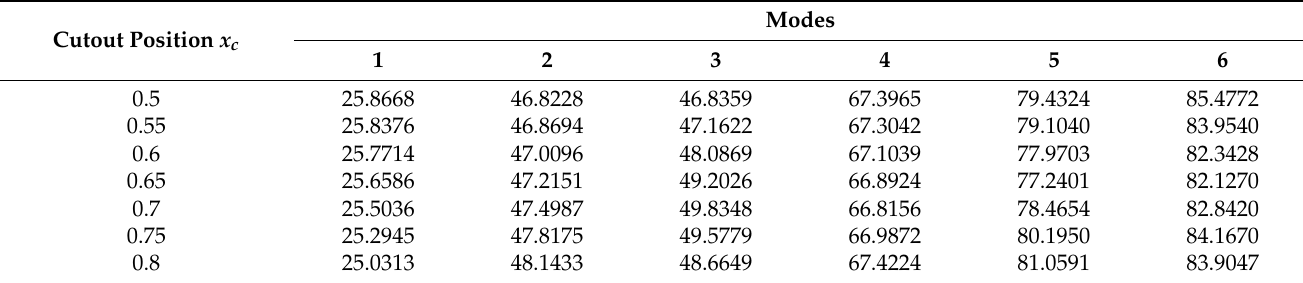
Table 9. The first six non-dimensional frequency parameters of the FGMs square plate with diverse cutout positions. Cutout Position x c